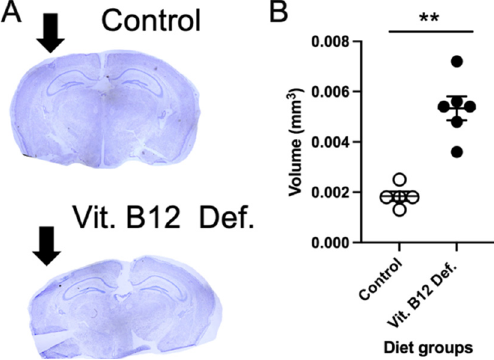
Figure 2. Impact of dietary vitamin B12 deficiency and ischemic stroke on damage volume. Repre- sentative cresyl violet image ( A ) and ischemic damage volume quantification ( B ). Depicted are means of ± SEM of four to five mice per group. ** p < 0.01, un-paired t -test.